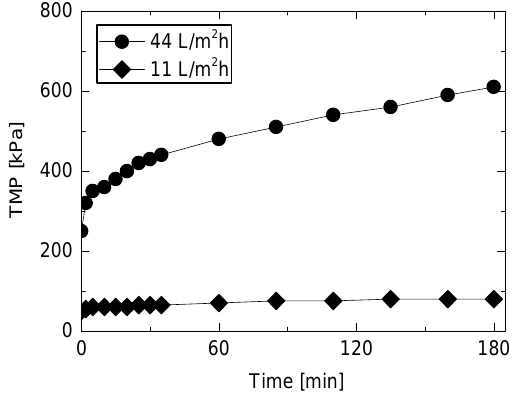
Figure 2. Transmembrane pressure (TMP) during NF filtration of the secondary wastewater effluent at permeate flux of 11 and 44 L/m 2 h (feed water temperature = 20 °C, cross ‐ flow velocity = 0.43 m/s).